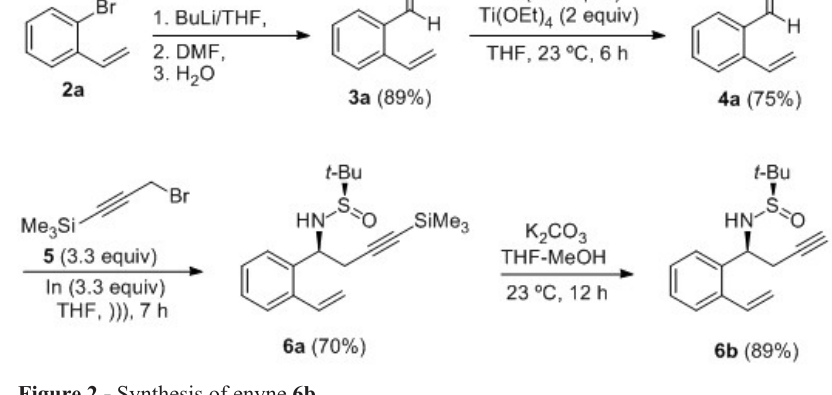
Figure 2 - Synthesis of enyne 6b .